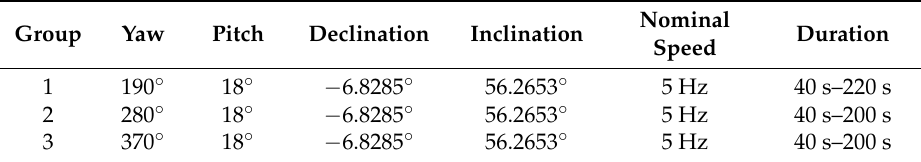
Table 4. Parameters of experiments.